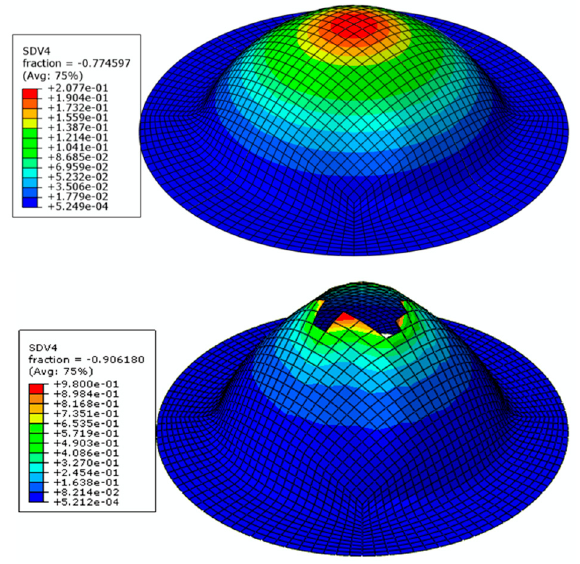
Figure 4. Bulge test damage distribution (isotropic damage model).